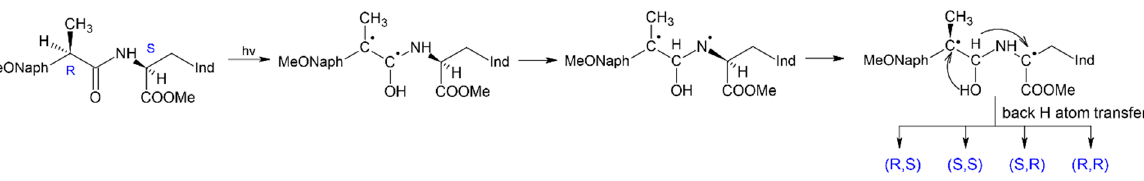
Figure 10. Scheme of photoinduced CI in ( R , S )-configuration of dyad I occurring through the stage of biradical formation and sequential rearrangement in the biradical resulted in formation of a biradical with paramagnetic centers located on pro-chiral centers, where MeONaph is 6-methoxynaphthalen-2-yl, Ind is indol-3-yl, asterisk denotes chiral centers. Adapted from [35], with permission from Elsevier. The use of these methods for studying CI became possible because the ( R , S )- and ( S , S